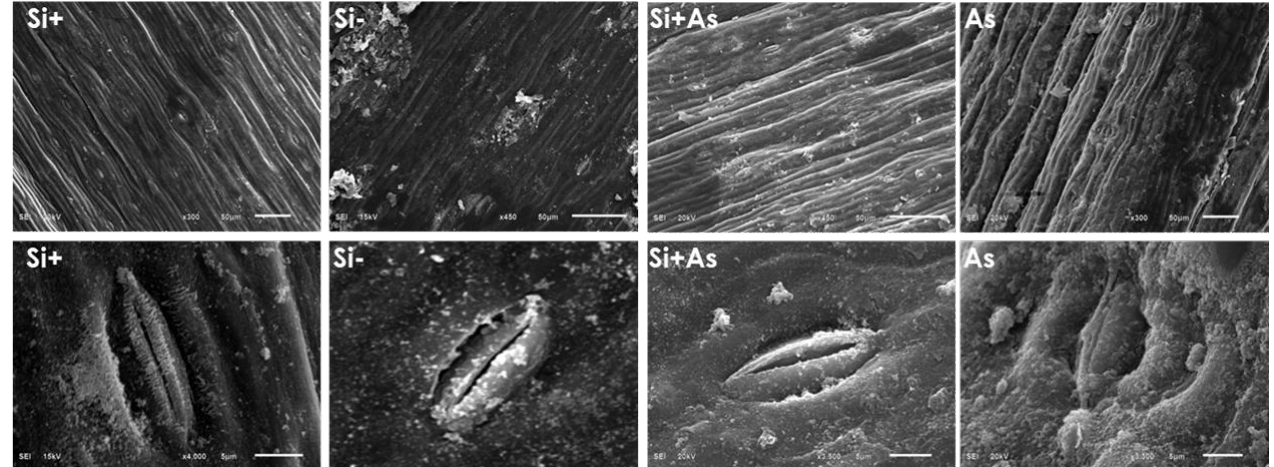
Figure 8. Physiological influence of silicon and arsenic on stomata apertures of date palm leaves, screened with scanning electron microscope. Silicon treated (Si+), silicon non-treated (Si − ), silicon and arsenic (Si + As), and arsenic treated (As). Three biological replicates were screened at magnification 3500×, scale bar = 5 µm.